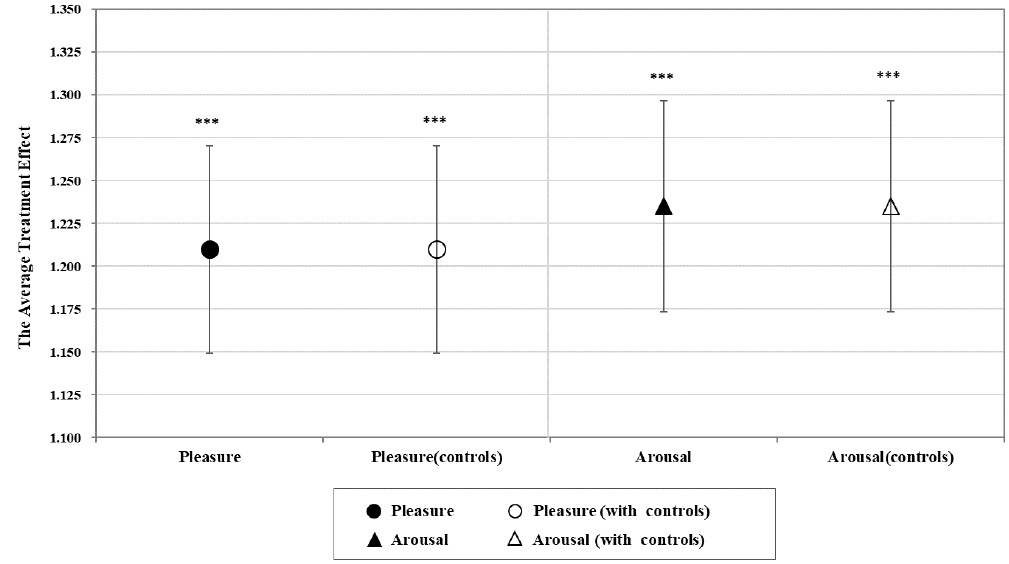
Figure 3. The effect of overall intervention on tourists’ momentary emotional experience. Note: Error bars represent 95% confidence interval. *** p < 0.001.